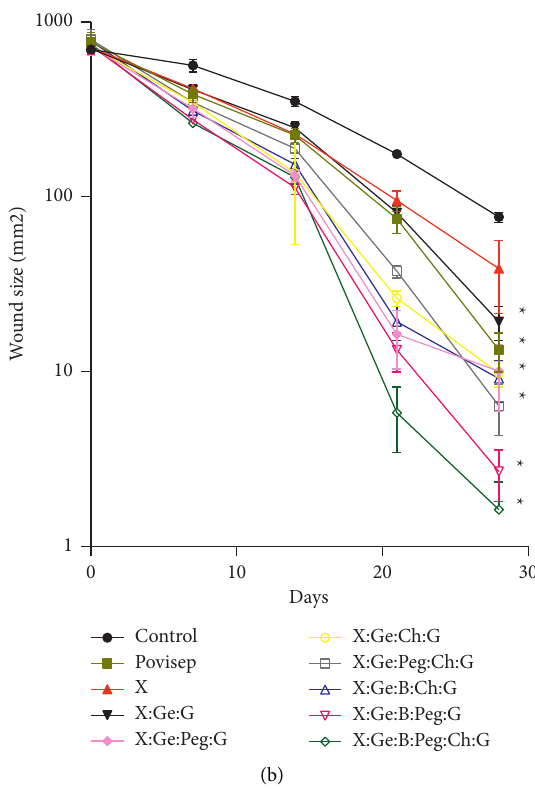
Figure 7: (a) Improvement of wound healing using hydrogel composites in an experimental second-degree burn of rat skin. Wounds treated with X :Ge :Peg :Ch: G, X :Ge :B :Peg :G, and X : Ge: B:Peg : Ch:G recovered the most after 28 days when compared to other hydrogel compositions. The presence of Peg and Ch in the formulations may explain for the hydrogel composites considerable wound contraction. Abbreviations. Xanthan gum (X), boric acid (B), gelatin (Ge), polyethylene glycol (Peg), chitosan (Ch), and glutaraldehyde (G). (b) Diagram of wound healing contraction rate. At the end of 28 days treatment period wound area of 28th day was analyzed using a two-way ANOVA coupled with Bonferroni posthoc test. ∗ Significantly different from control, none of the hydrogel treated groups were significantly different from the povisep group ( p < 0 . 05). Abbreviations. Xanthan gum (X), boric acid (B), gelatin (Ge), polyethylene glycol (Peg), chitosan (Ch), and glutaraldehyde